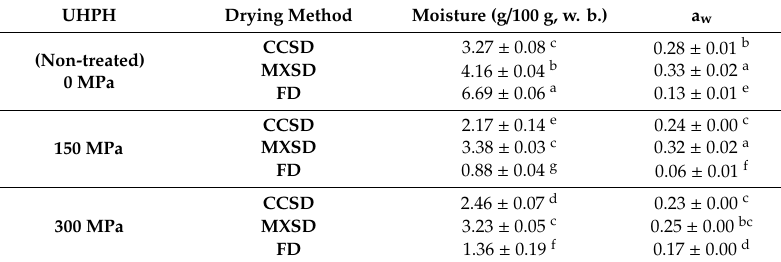
Table 2. Moisture content and water activity (a w ) values of L. plantarum NRRL B-1927 powders †